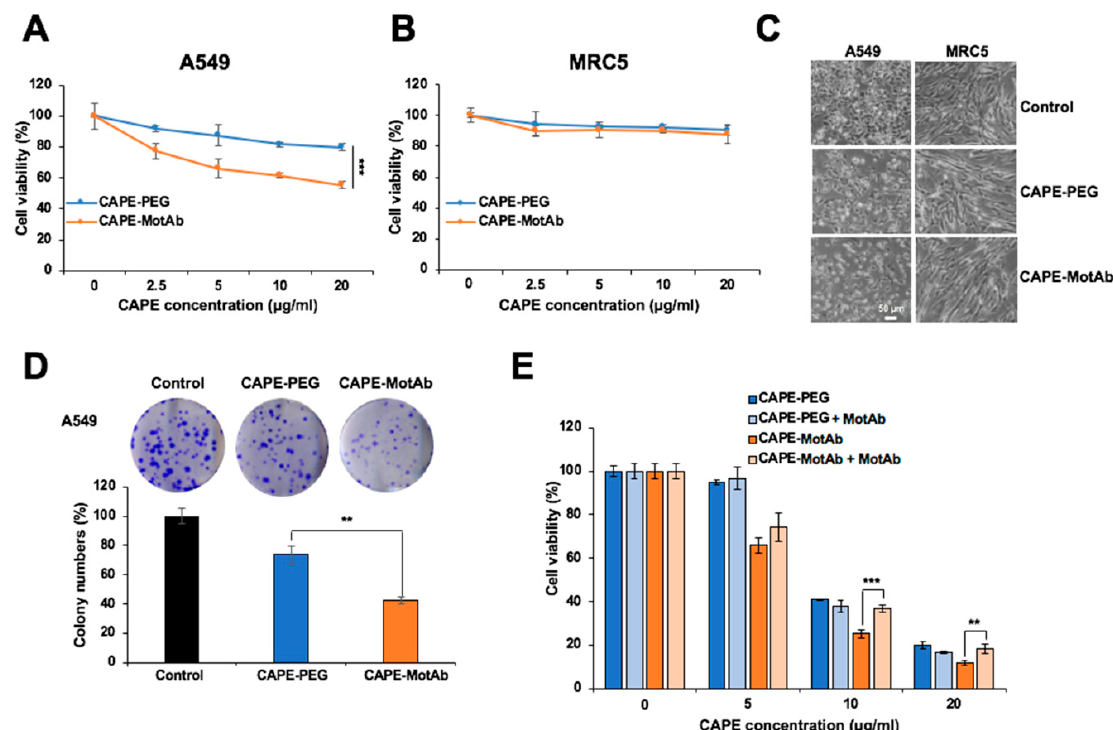
Figure 3. Enhanced selective cytotoxicity of CAPE-MotAb in vitro. ( A ) Cell viability assay indicated dose-dependent cytotoxicity of CAPE-PEG and CAPE-MotAb in A549 cancer cells treated for 24 h. CAPE-MotAb enhanced cancer-killing activity of CAPE in A549 cells, but not in MRC5 normal cells ( B ) (mean ± SD, n = 3), *** p < 0.001 (Student’s t-test). ( C ) Phase-contrast images showing toxicity of CAPE-MotAb (CAPE concentration: 20 µ g / mL) in human cancer cells; MRC5 normal cells did not show significant toxicity after 24 h incubation. ( D ) A stronger reduction in colony-forming ability was observed in cells treated with CAPE-MotAb (CAPE concentration: 20 µ g / mL). Quantitation from three independent experiments (mean ± SD, n = 3), ** p < 0.01 (Student’s t-test). ( E ) Cell viability of A549 cells treated with CAPE-PEG and CAPE-MotAb with / without MotAb (0.8 µ g / mL) for 48 h (mean ± SD, n = 3), * p < 0.05, ** p < 0.01, *** p < 0.001 (Student’s t-test). CAPE-MotAb caused a dose-dependent decrease in cell viability, partially compromised by preincubation / simultaneous with MotAb.